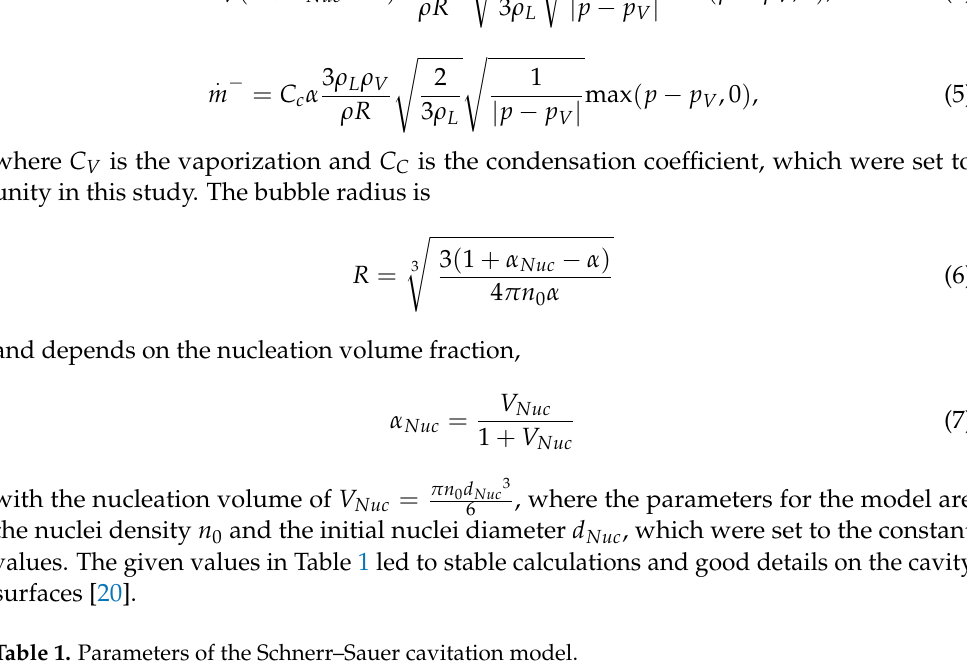
Table 1. Parameters of the Schnerr–Sauer cavitation model. Parameter n 0 d Nuc Unit 1/ m 3 m Value 1 · 10 12 1 · 10 −